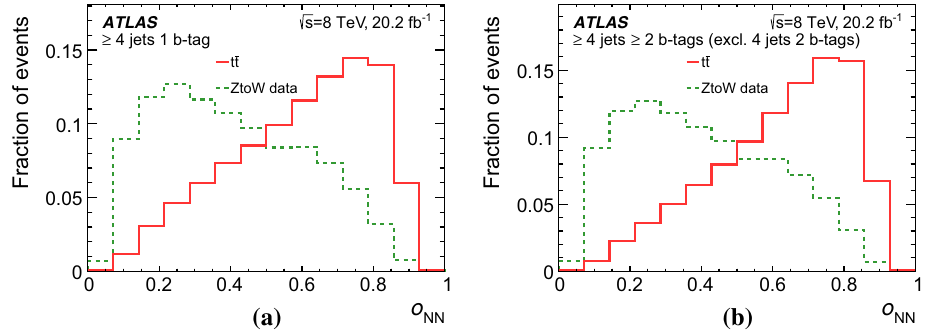
Fig. 3 Probability densities of the neural-network discriminant o NN for the simulated t ¯ t signal process and the W +jets background process derived from data using converted Z +jets events a for SR1 and b for SR3